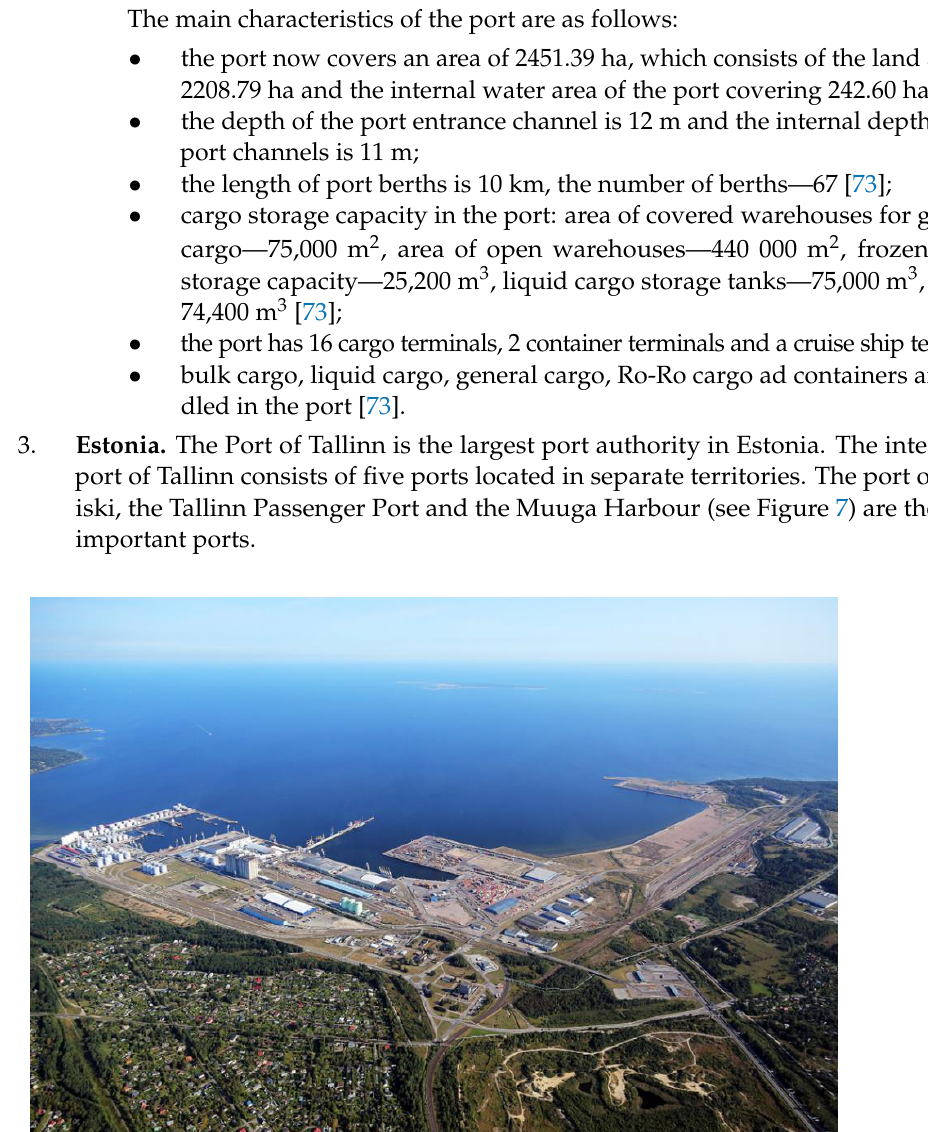
Figure 6. Port of Liepaja. Source: [72].